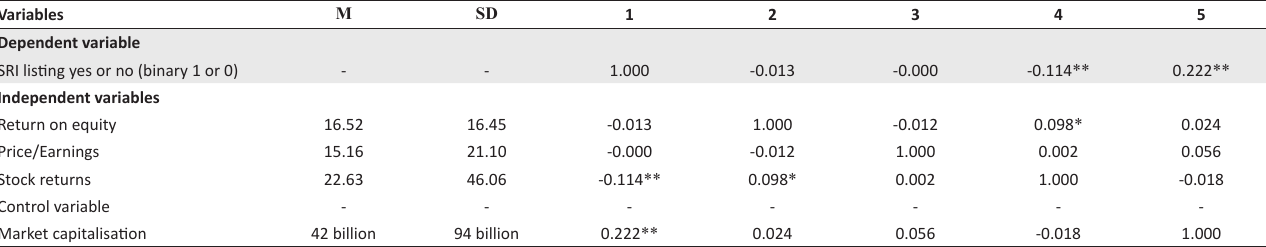
TABLE 2: Descriptive statistics for the data set ( n = 885).